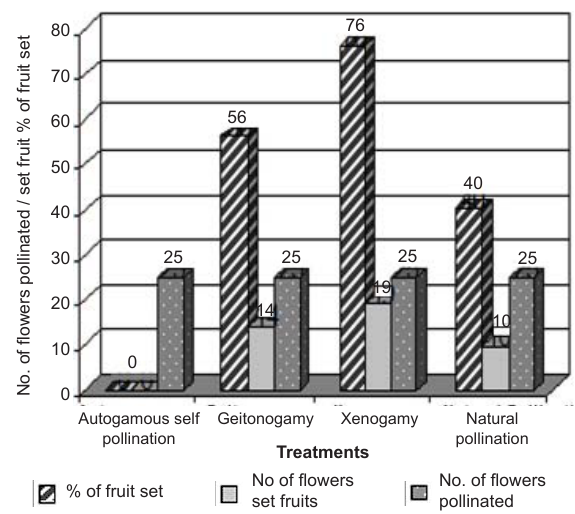
Figure 2. Fruit set in different modes of pollination systems in Impatiens